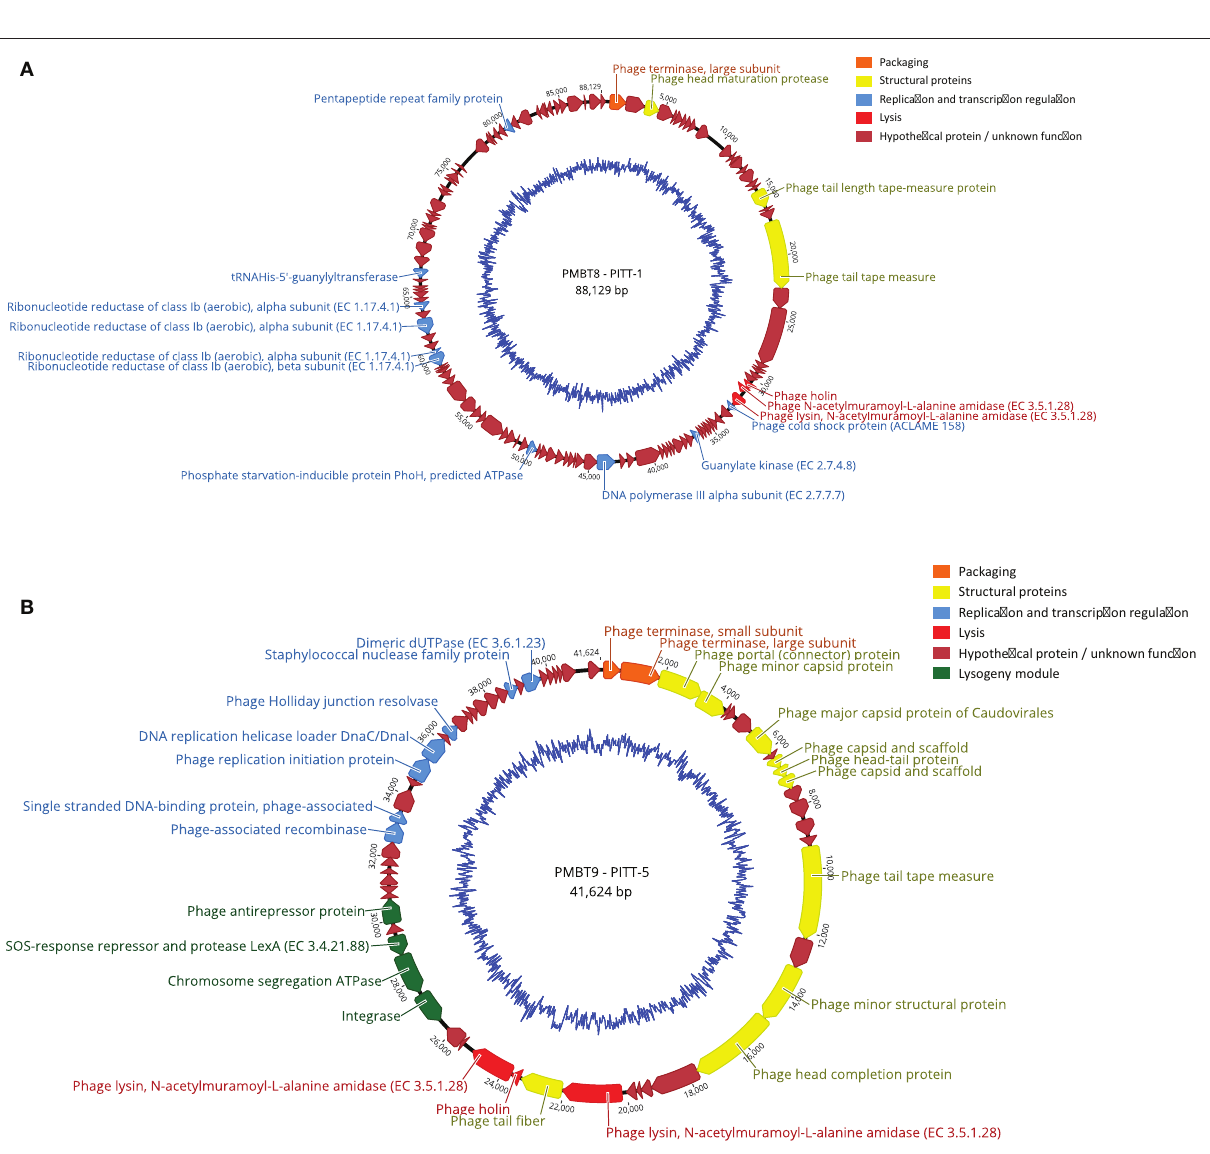
FIGURE 3 | (A,B) Genome map of phages PITT-1 (PMBT8, 88,129 bp, A ) and PITT-5 (PMBT-9, 41,624 bp, B ) with structural and functional annotations. An automated annotation was obtained from PATRIC and all ORFs were subsequently manually annotated with BLASTP and SMART. Arrows indicate the predicted ORFs, which are labeled and color-coded based on their predicted function. The genomes are shown starting upstream of ORF1 that specifies the phage terminase large subunit. The ORFs involved in DNA packaging are marked in orange, the ORFs for structural proteins are marked in yellow and the ORF involved in lysis is marked in red. Blue arrows represent ORFs for phage DNA transcription and replication. Hypothetical ORFs and ORFs with no phage-related function are shown in dark red. The genome maps were generated using Geneious version